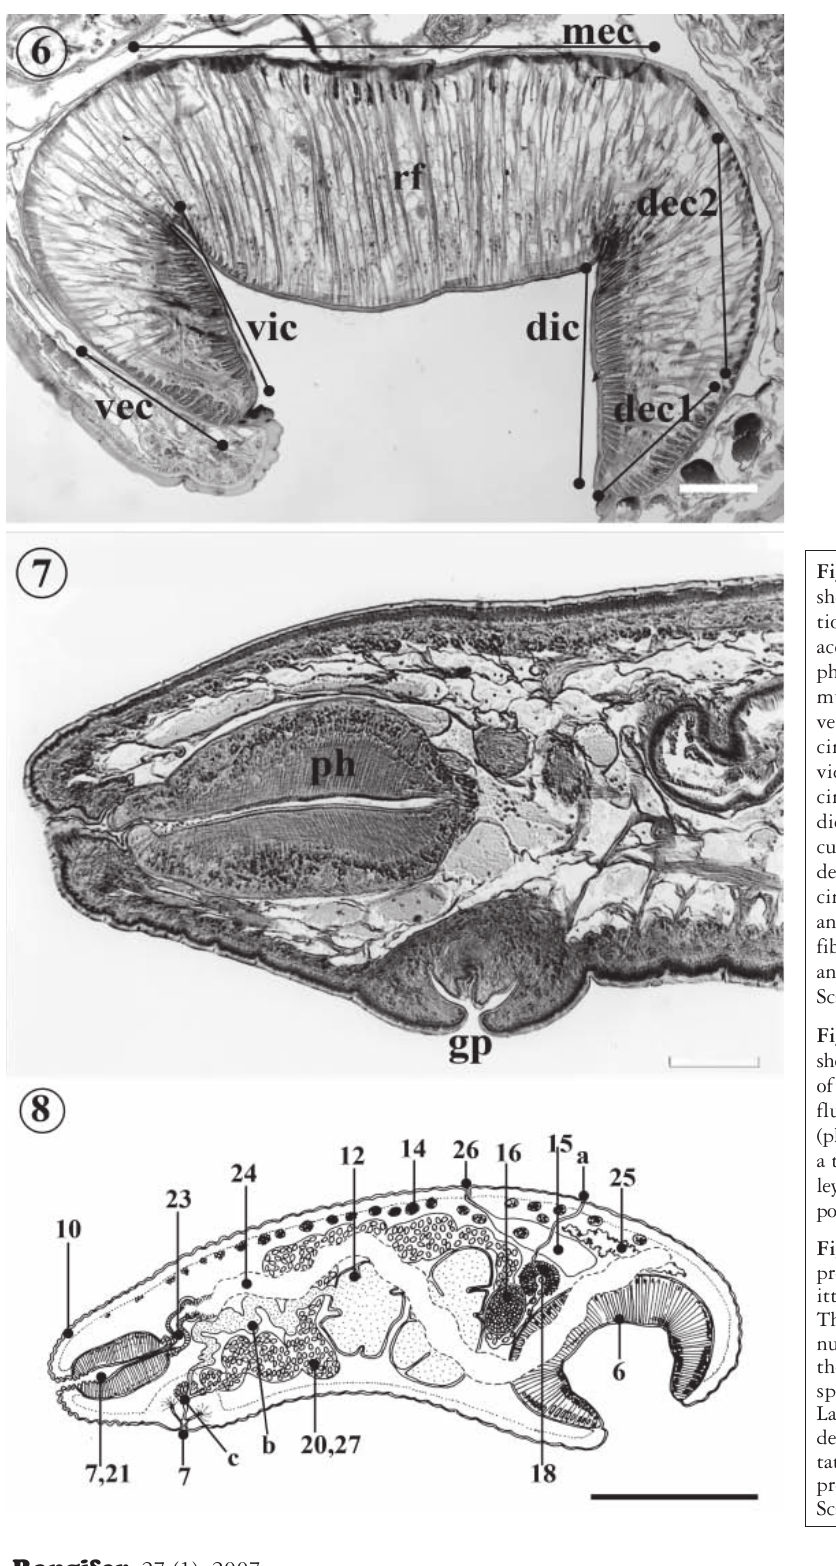
Fig. 6. LM micrograph showing a sagittal sec- tion of the subterminal acetabulum of param- phistomum type. Key to muscle abbreviations: vec = ventral exterior circular muscle series, vic = ventral interior circular muscle series, dic = dorsal interior cir- cular muscle series, dec1, dec2 = dorsal exterior circular muscle series 1 and 2, rf = radial muscle fibers, and mec = medi- an circular muscle series. Scale bar = 200 µm. Fig. 7. LM micrograph showing a sagittal section of the anterior end of the fluke with a pharynx (ph) of liorchis type and a terminal genitalium of leydeni type: gp = genital pore. Scale bar = 200 µm. Fig. 8. Diagrammatic presentation of the sag- ittal view of P. leydeni . The areas indicated with numbers are depicted in the figures with corre- sponding numbers. Laurer’s canal (a), vas deferens (b), and pros- tate gland (c) are not presented in the figures. Scale bar = 2